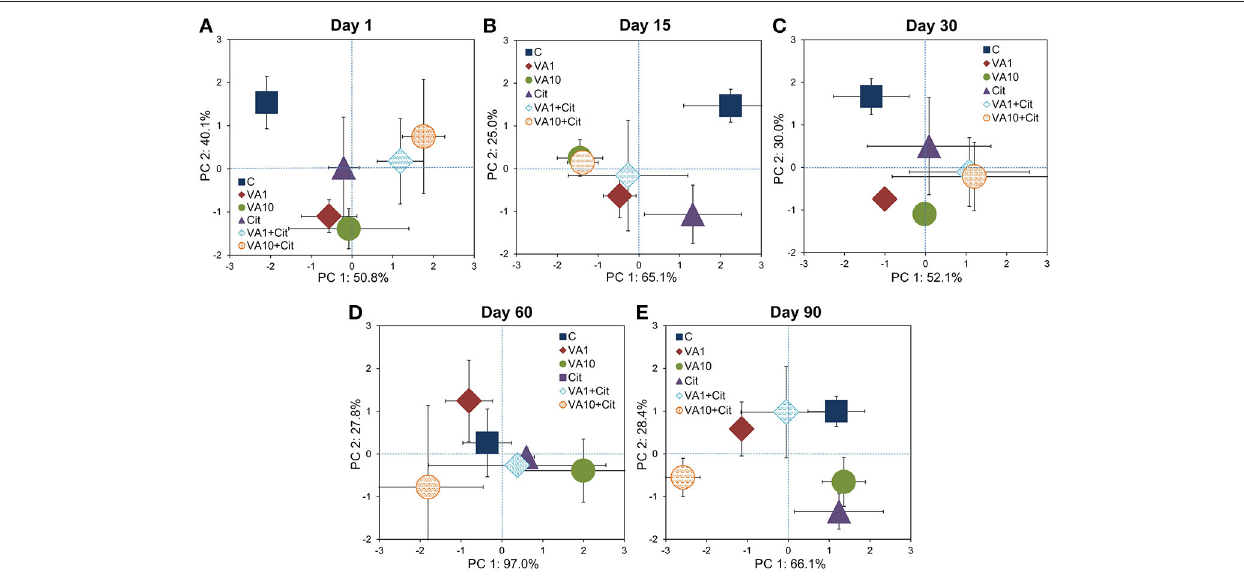
FIGURE 2 | Results of the PCA analysis based on the CLPP indices on days 1 (A) , 15 (B) , 30 (C) , 60 (D) , and 90 (E) . The explanation of the treatment abbreviations is given in Figure 1